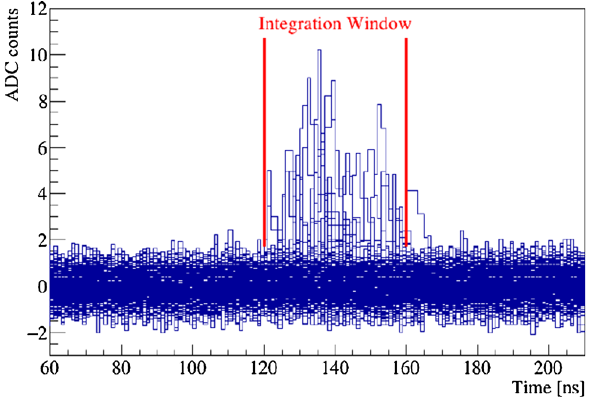
Fig. 6 Single-PE response of the bottom PMT in linear scale. The two and three-PE distributions are two small to be